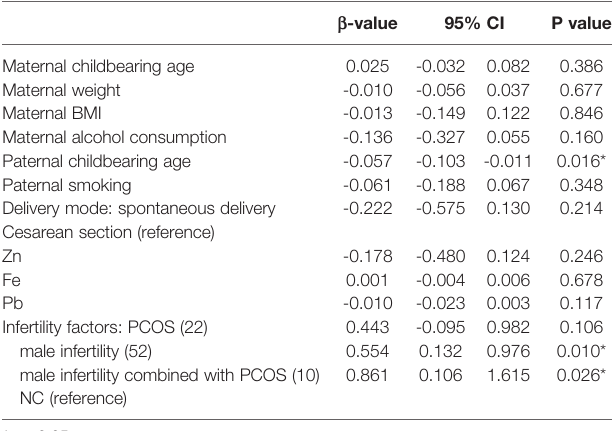
TABLE 4 | Multiple linear regression analysis of bone mineral density — Infertility factors.